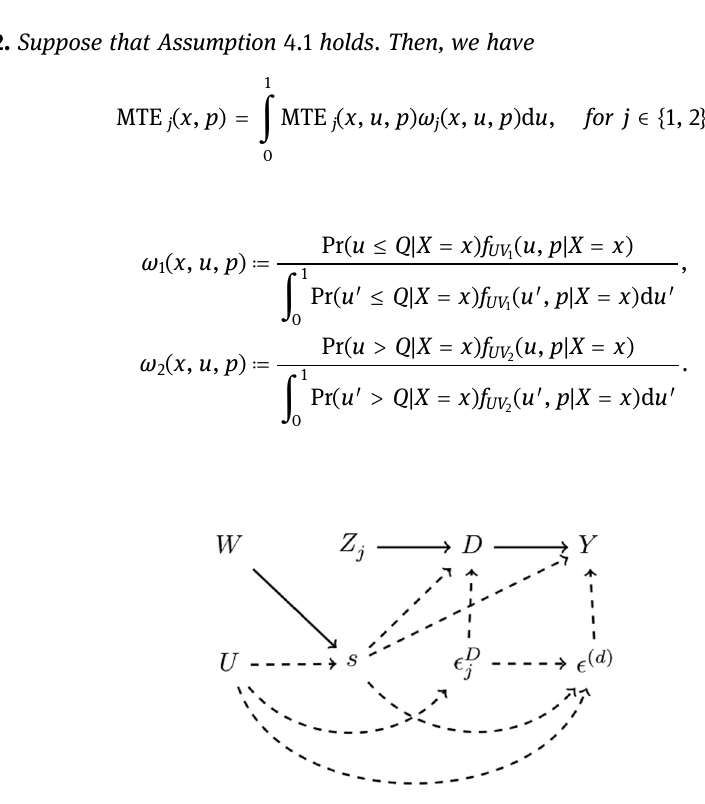
Figure 2: DAG under Assumption